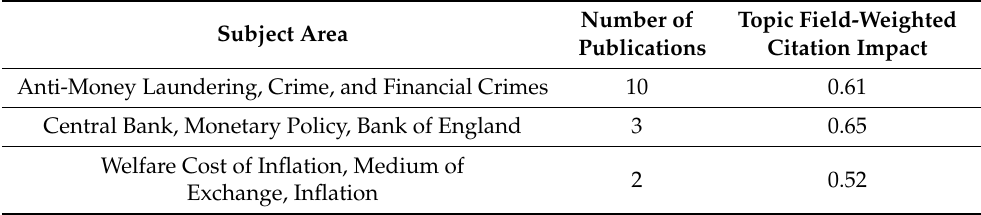
Table 10. Scholarly contribution of Masciandaro,